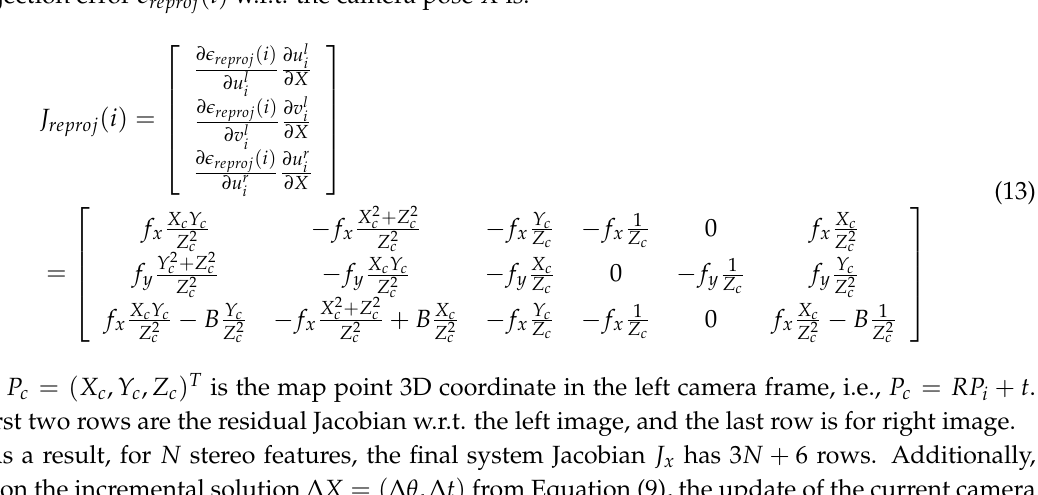
Figure 7. The navigation frame is a local NED (North-East-Down) frame, and the initial position is determined by the first GPS measurement. The EKF estimates the IMU body frame pose w.r.t. the navigation frame. The transformation from the camera frame to the IMU body frame is denoted as T is , and the GPS receiver coordinate in the IMU body frame is t ig